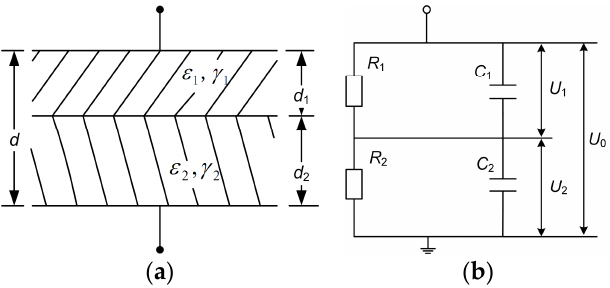
Figure 7. The ( a ) double-composite dielectric model and ( b ) corresponding equivalent circuit.